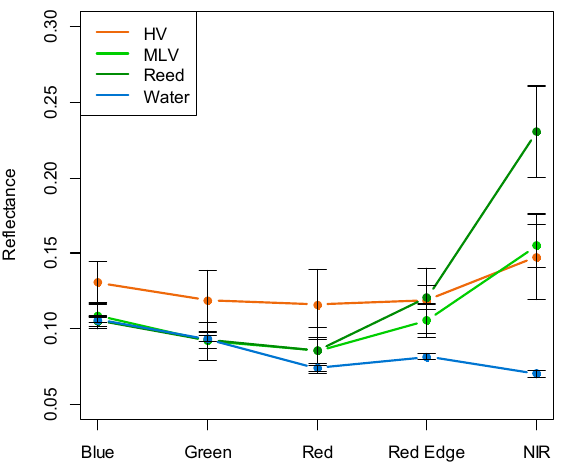
Figure 5. Spectral signatures of training data (RapidEye image). Dot and error bar represents the mean and standard deviation of reflectance, respectively.